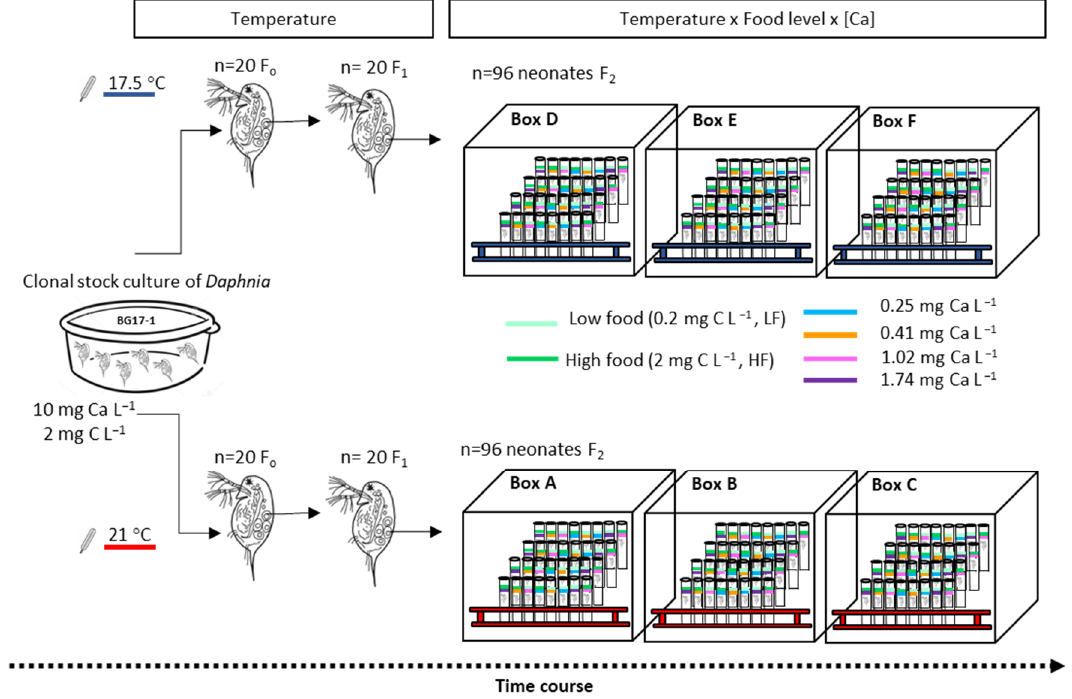
Figure 2. Schematic diagram of the experimental design to test the combined effects of a Ca gradient at two temperatures and low (LF) or high (HF) food quantity on the survival and reproduction of D. pulex .